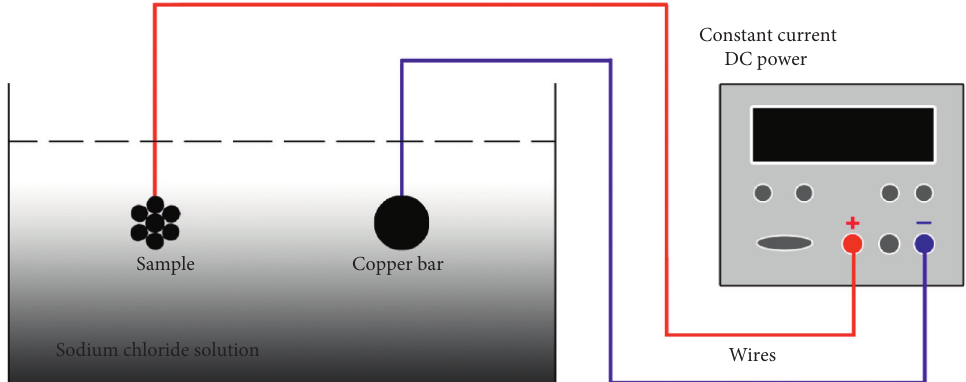
Figure 1: Diagram of the anchor cable electrolytic corrosion test for unstressed anchor cable.